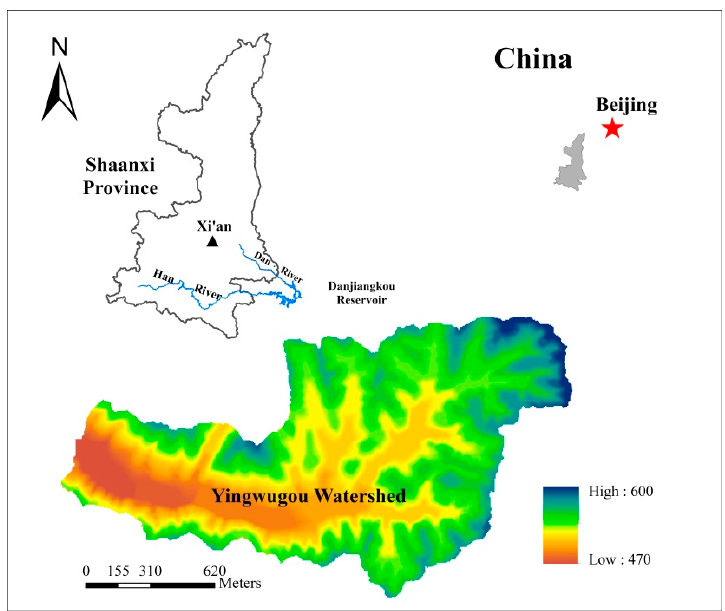
Figure 1. Location of the study area.